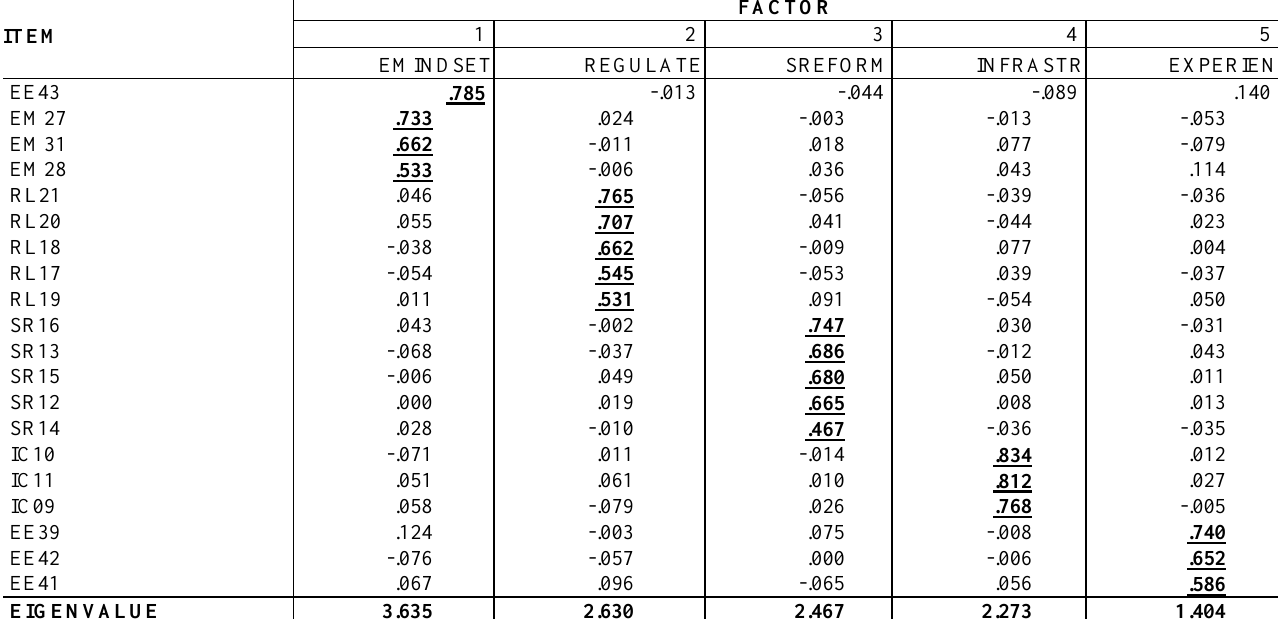
Table 1: Rotated factor loadings: Antecedent variables